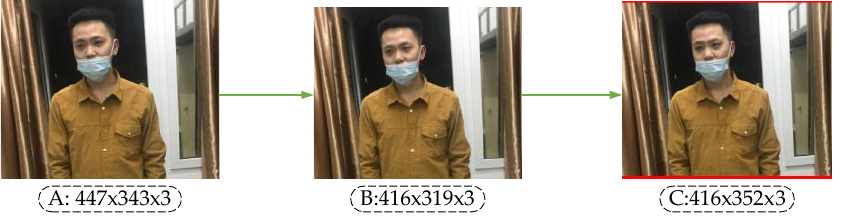
Figure 7. Adaptive image scaling.